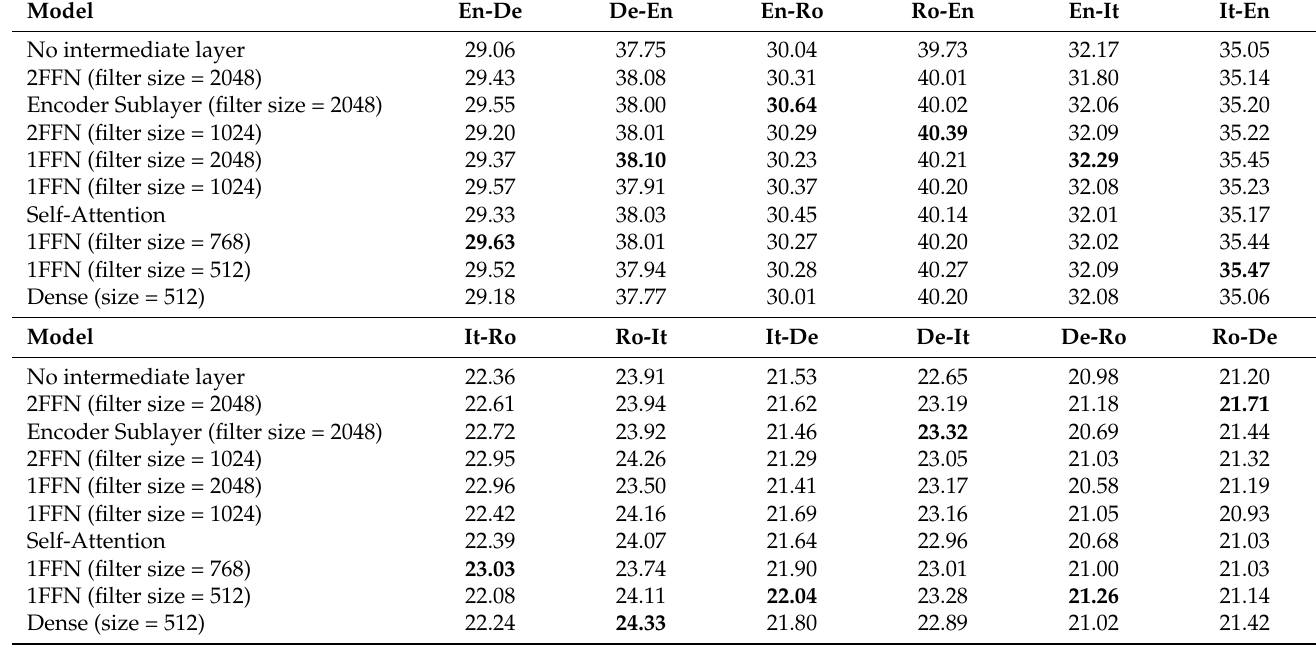
Table 3. Comparisons of the fine-tuning models with various intermediate layers for each translation pair. FFN is the feed-forward network with ReLU activation. Dense is a fully connected layer with layer normalization and dropout. Results below ‘No intermediate layer’ are sorted by the number of parameters in decreasing order. We indicate the best scores with bold